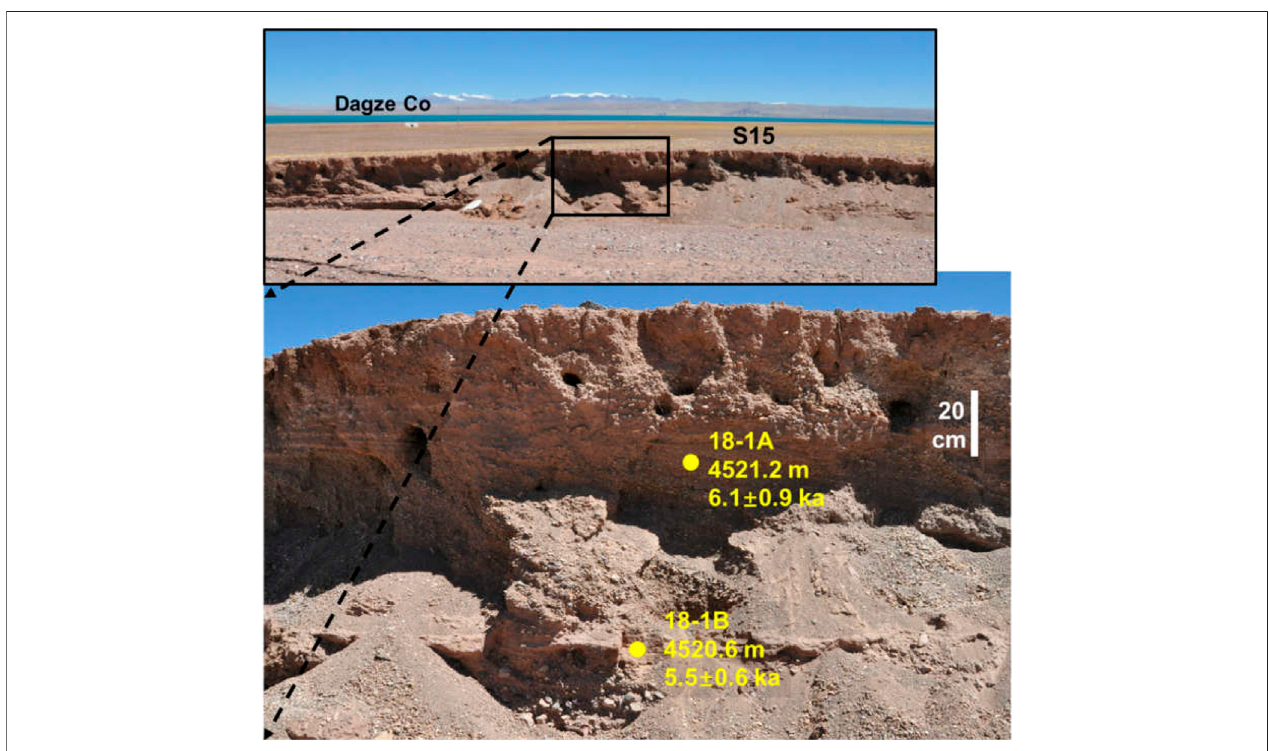
FIGURE 4 | Paleoshoreline S15 and pro fi le 18 – 1. This shoreline is the highest visible paleoshoreline surrounding the lake and extends from the southern to the eastern lake margin. OSL dating sample 18-1A was collected from the beach gravels where there is a large sand component. OSL dating sample 18-1B was collected from the middle part of the medium sand